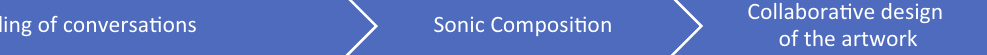
Figure 1. Creation